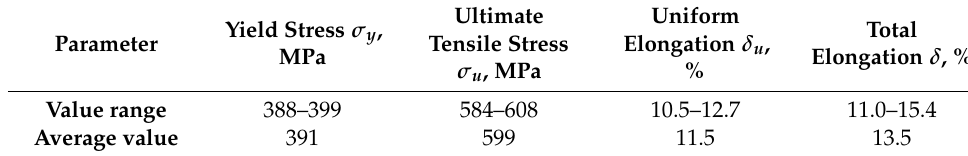
Table 2. Mechanical properties of the 30 KhGSA steel (results of 6 specimens